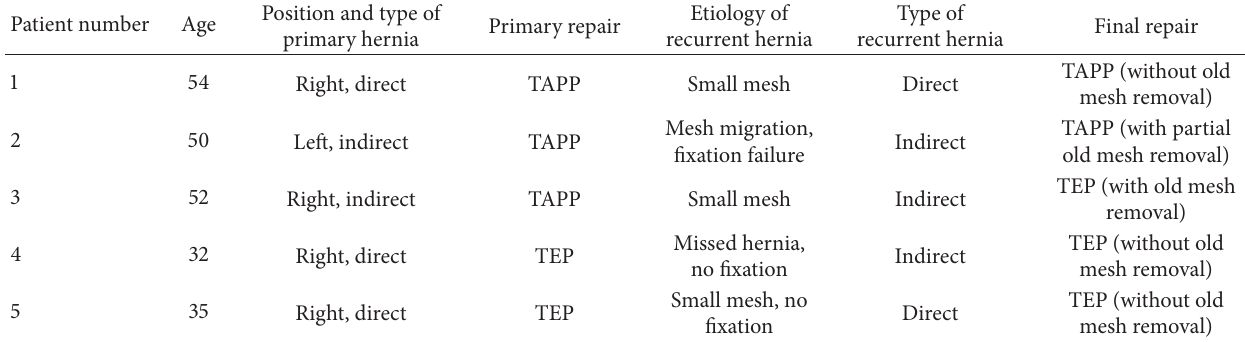
Table 1: Patient demographic data, hernia characteristics, and operative